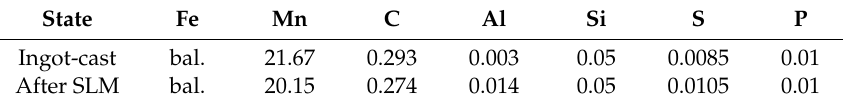
Table 1. Chemical composition of the investigated steel after ingot casting and after sample production via SLM. All contents are given in wt %.